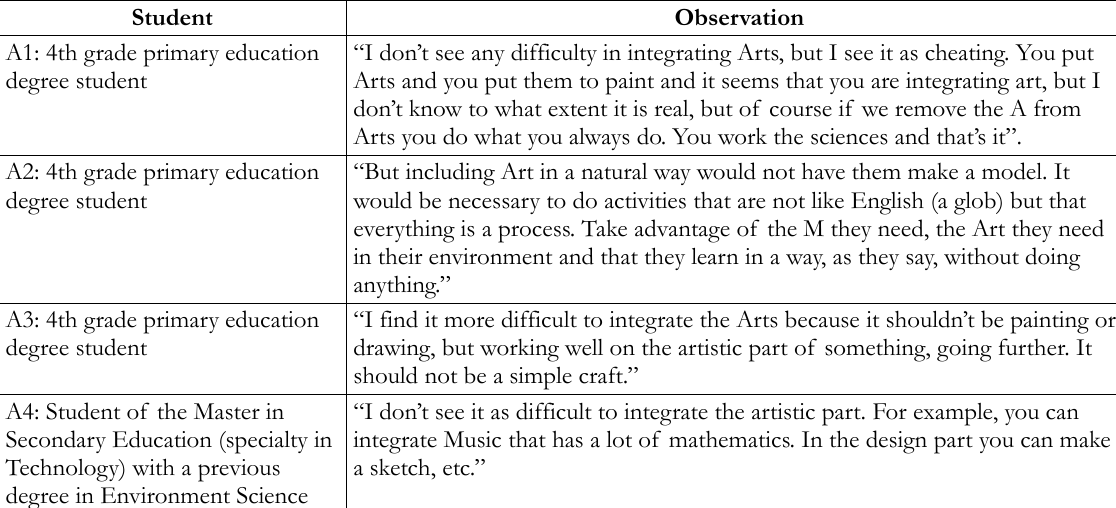
Table 5. Answers related to the category “Difficulty for the inclusion of